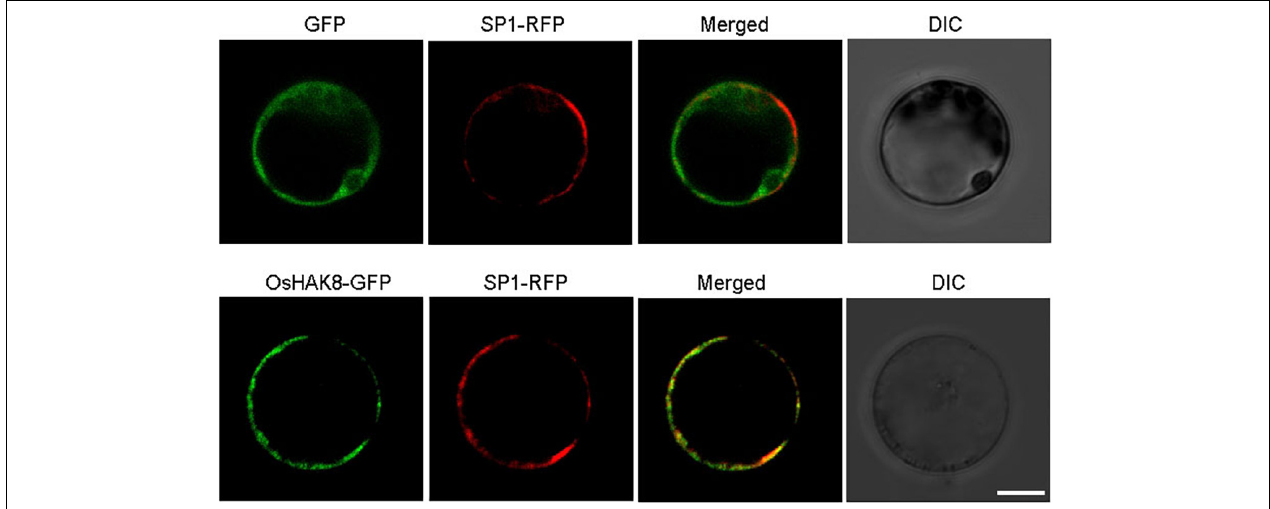
FIGURE 4 | Plasma membrane localization of OsHAK8. The GFP coding sequence was fused to the C-terminus of the OsHAK8 coding region in the pCambia2300 vector and then transformed into rice mesophyll protoplasts. GFP alone in the same vector was used as a control. Signals from GFP, OsHAK8-GFP, and SP1-RFP (a plasma membrane localization marker) were imaged using a Zeiss LSM880 confocal laser scanning microscope. Columns 1–4 show GFP signals, SP1-RFP signals, merged images of GFP and RFP signals, and bright-field differential interference contrast (DIC), respectively. For each localization experiment, ≥ 30 individual cells were analyzed using a Zeiss LSM880 confocal laser scanning microscope (Carl Zeiss). Bar = 10 µ